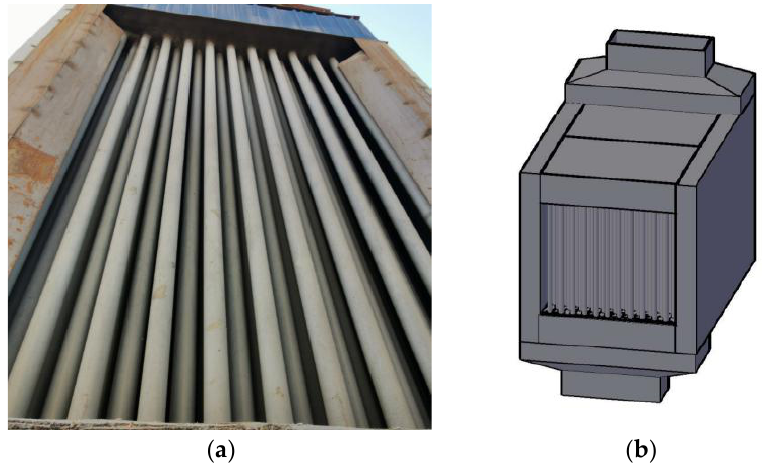
Figure 2. The scene graphs of the HE and the 3D model of the HE: ( a ) scene graph of HE; ( b ) 3D model of HE.